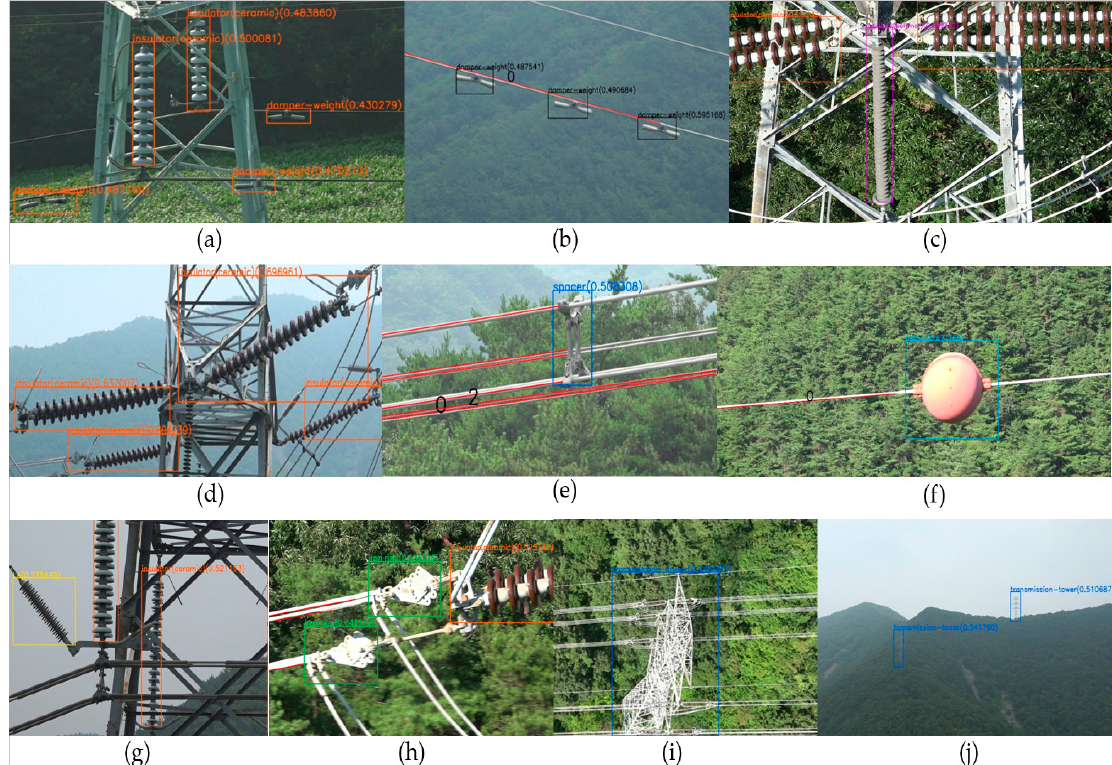
Figure 3. Detection results of the di ff erent types of electrical components, ( a , b ) PorSTI-W and damper weights, ( c , d ) PorSTI-R and PolSTI, ( e ) spacer, ( f ) balisor, ( g ) LA and PorSTI-W, ( h ) sag adjusters and PorSTI-R, and ( i , j ) transmission towers, by the trained transmission line components detector. Every components appear with a random orientation, view-point, lighting conditions, shapes, colors and scales, yet the CNN-based detector is able to detect them